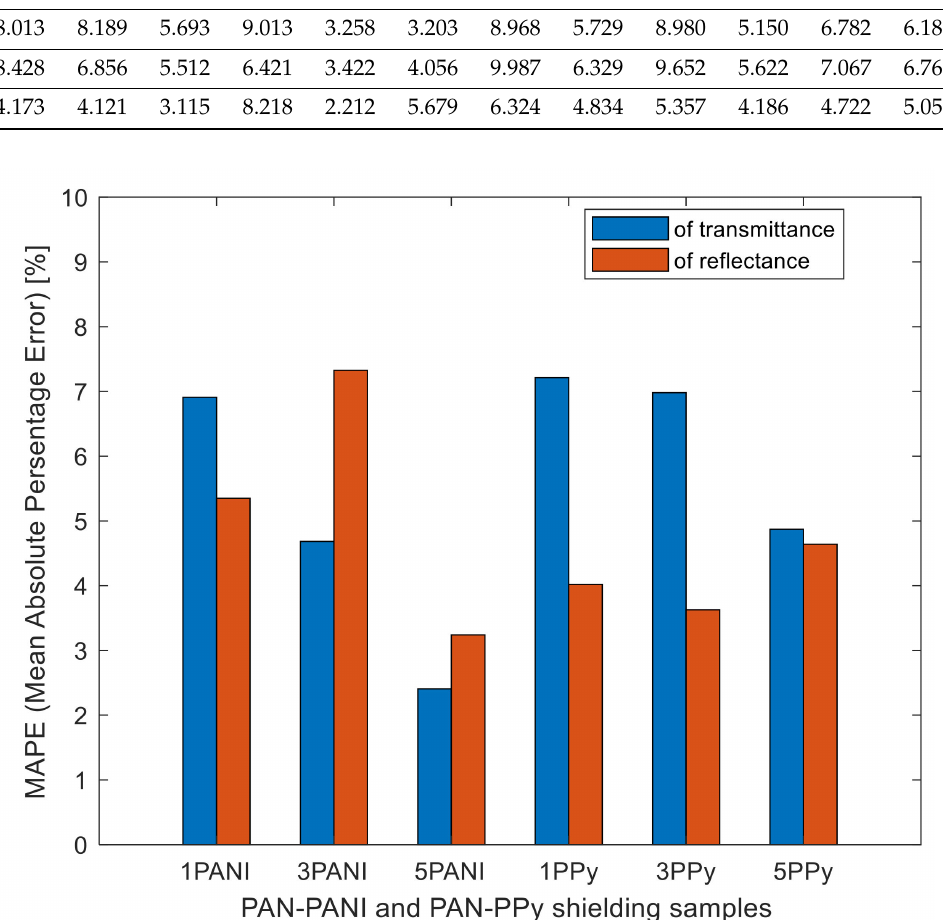
Figure 15. Average value of MAPE errors for the transmittance and reflectance in the entire measuring range from 2.5 to 18